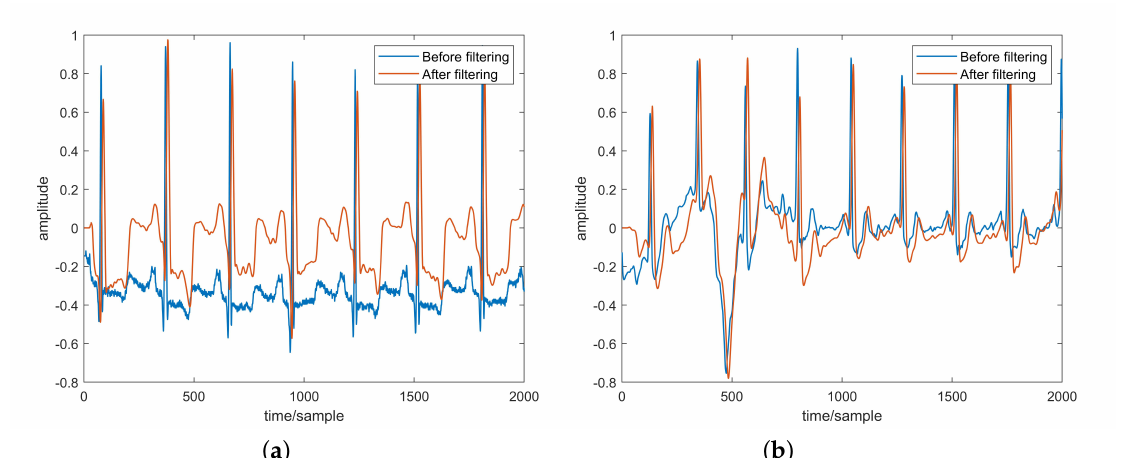
Figure 4. Original and pre-processed ECG signal diagrams of the datasets: ( a ) Original and pre- processed ECG signal diagram of the MIT-BIH dataset; ( b ) Original and pre-processed ECG signal diagram of the CinC_2017